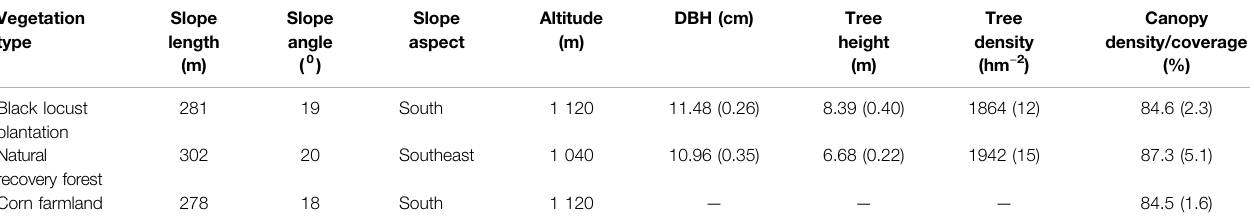
TABLE1| Basicinformationontheresearchsite(Caijiachuancatchment,ShanxiProvince,NorthChina).DBH (cid:2) diameteratbreastheight;canopydensityisprovidedforthe forested sites and coverage is provided for the corn farmland; “ − ” (cid:2) not measured. The values presented are the means and SD in brackets. Vegetation type